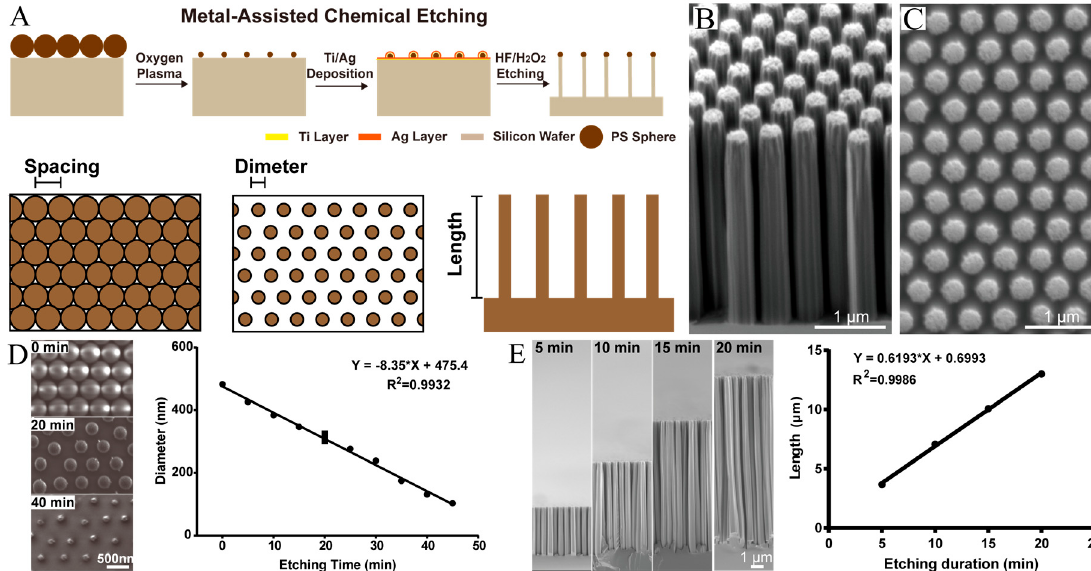
Figure 1. Fabrication and characterization of the SiNR array. ( A ) Scheme of chemical etching process for fabricating SiNRs. The spacing, dimeter, and length of the nanorods are controllable. ( B ) SEM image of SiNR array (45° title view). The length of nanorods are uniform. ( C ) SEM image of SiNR array (top view). The diameters of nanorod are uniform. ( D ) The left panel is selected SEM images of PS spheres after oxygen plasma etching (0 min, 20 min, and 40 min). The right panel shows the correlation between the diameter of PS sphere and the etching time of oxygen plasma. A significant negative correlation was observed between the diameter and the etching time (R 2 = 0.9932, p < 0.0001). ( E ) The left panel presents SEM images the SiNR array (sectional view) after chemical etching (5 min, 10 min, 15 min, and 20 min). The right panel shows the correlation between the length of SiNR array and the etching time of oxygen plasma. A significant positive correlation was observed between the diameter and the etching time (R 2 = 0.9986, p < 0.0001).